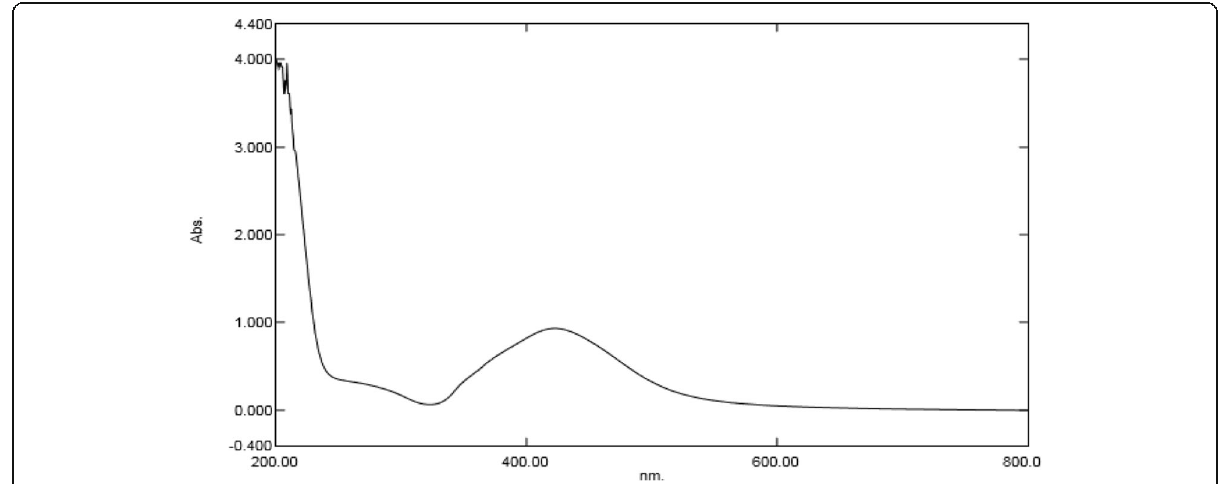
Fig. 1 UV spectrum of colloidal solution of silver nanoparticles